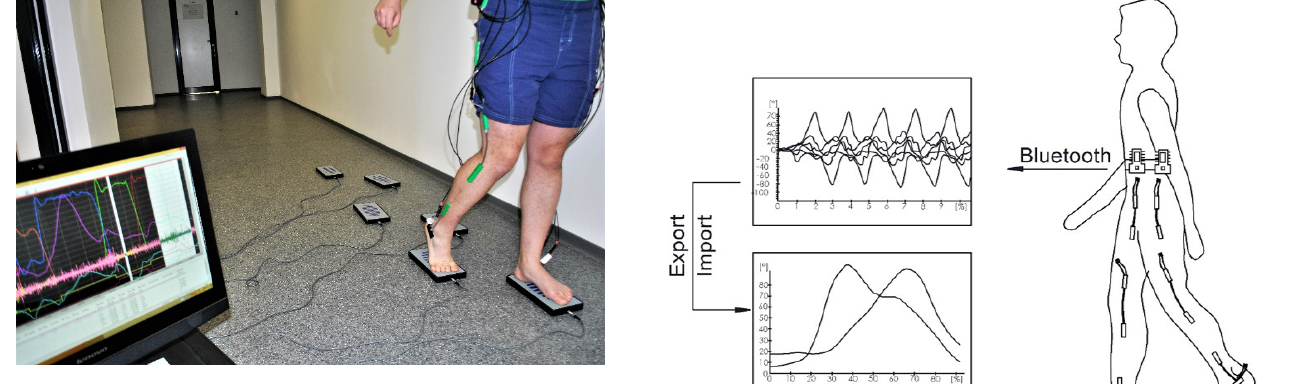
Figure 1. Goniometers and Datalog devices mounted on the human subject, during the test.